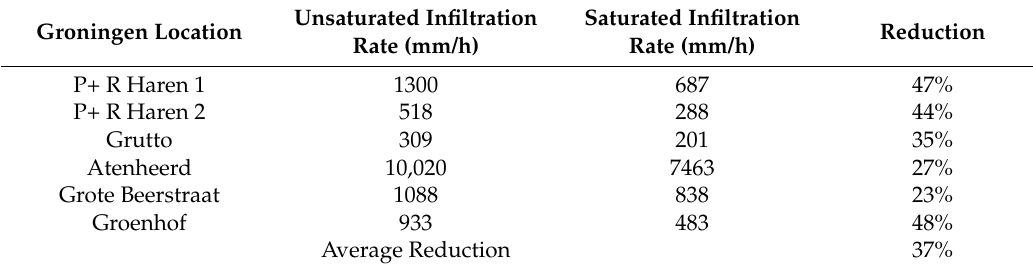
Table 3. Comparison of three FSIT tests at the Goirle 2 site.